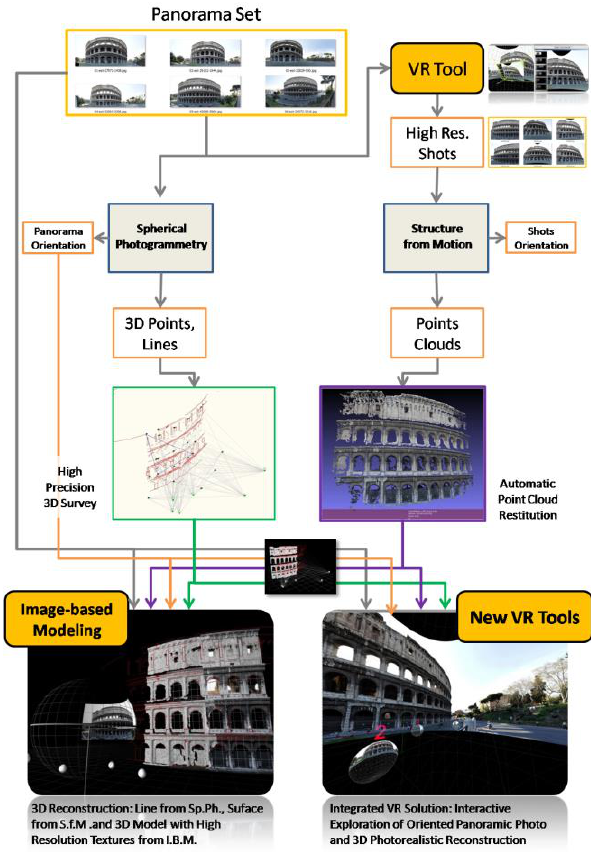
Figure 4. Workflow diagram describing the proposed pipeline